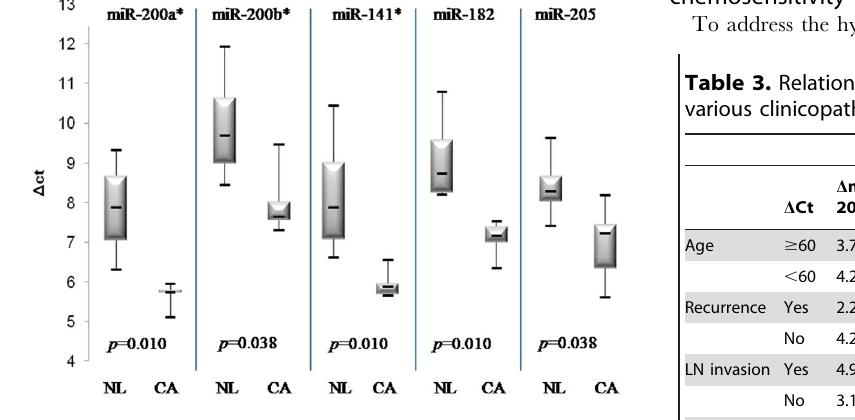
Figure 3. Up-regulated expression of five miRNAs in fresh- frozen endometrial cancer tissues and cells. foot note: NL, Normal; CA, Cancer. p -values were obtained using the Mann–Whitney test.